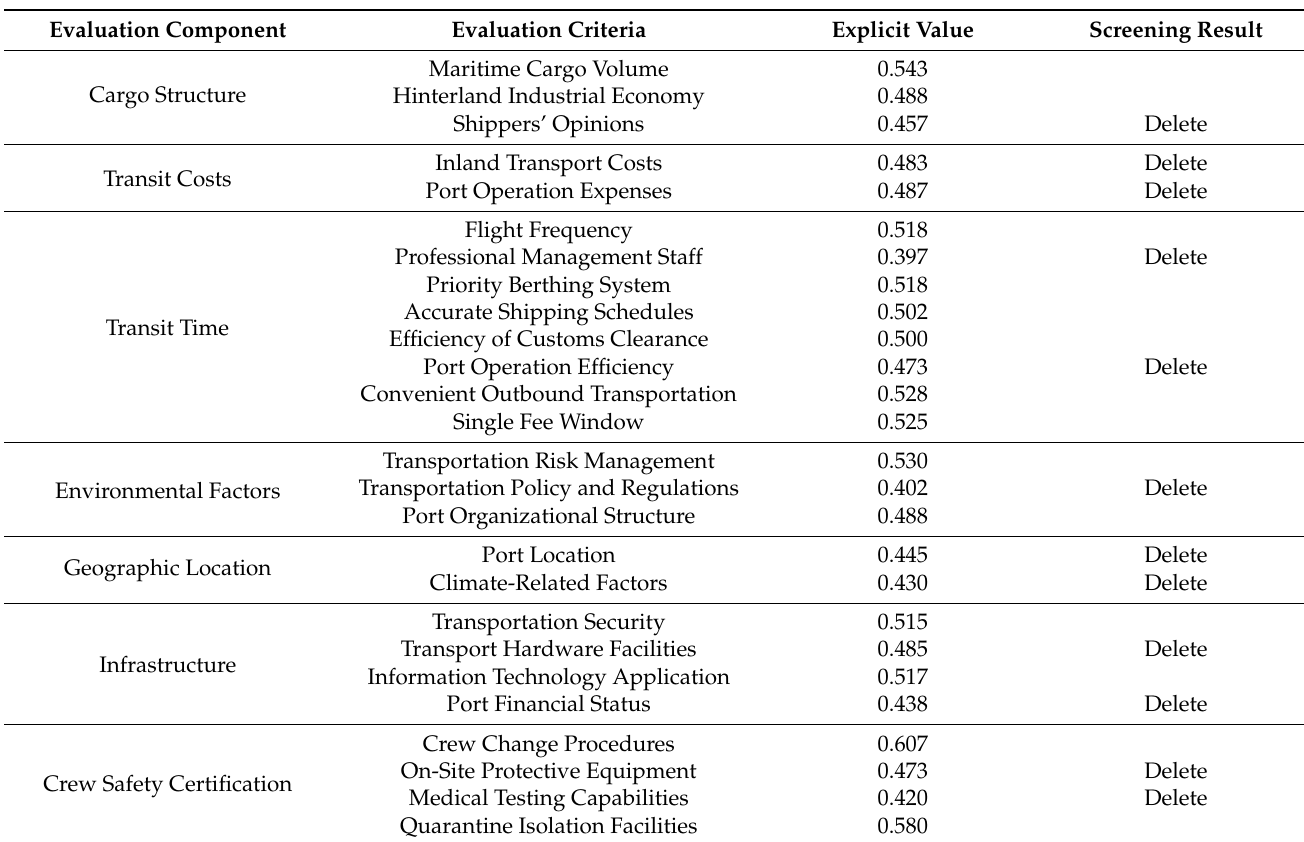
Table 3. Sub-group suitability analysis of factors influencing the selection of crew change transit ports by